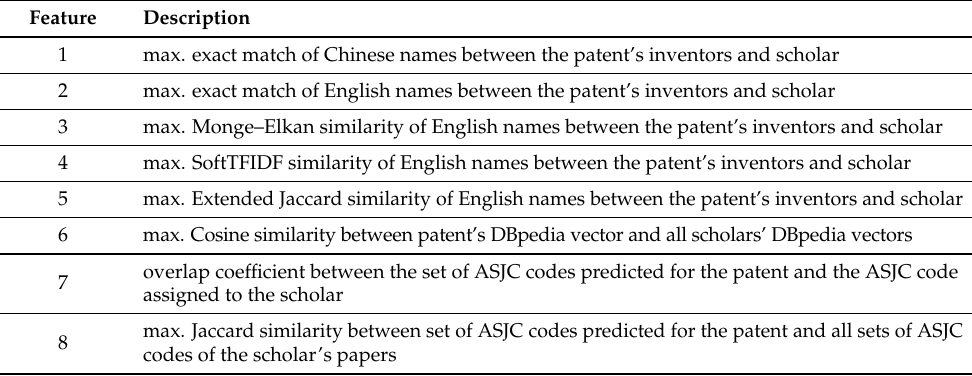
Table 1. Overview of features used for record